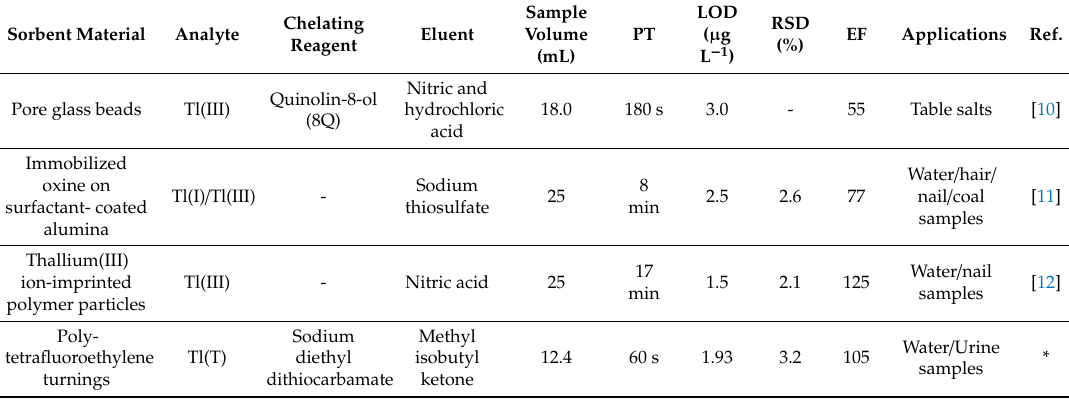
Table 3. Comparison of analytical performance characteristics of the developed method with those of other reported on-line FI–SPE–FAAS methods for thallium determination.